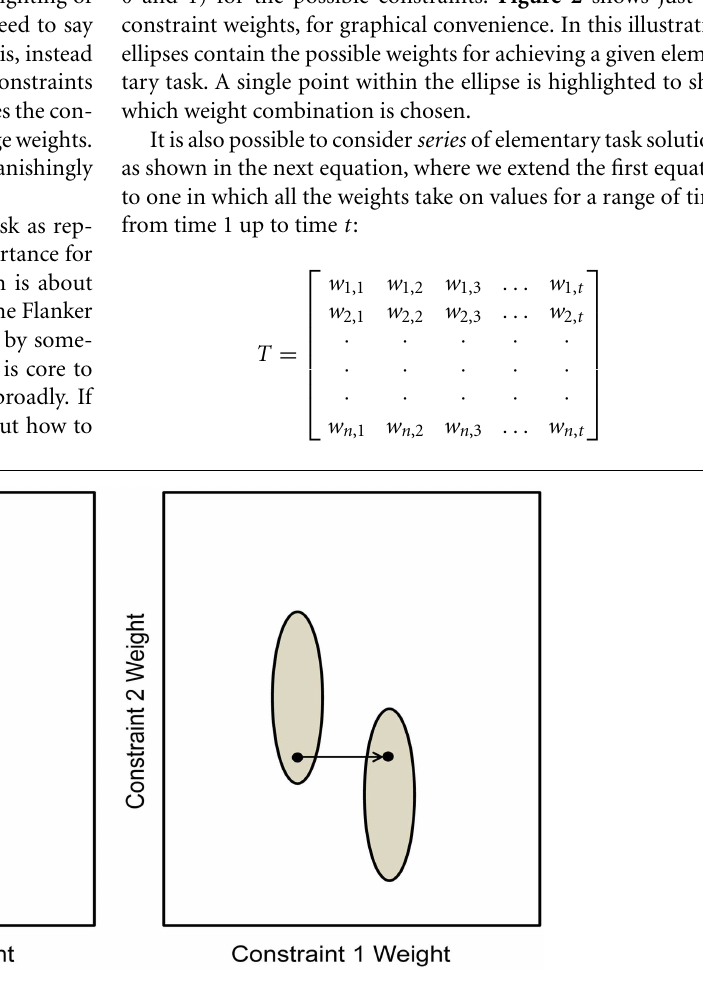
FIGURE 2 |Actions selected from those that satisfy elementary task demands (enclosed in ellipses) defined by their locations in the two-dimensional space of weights (0–1) for constraint 1 and constraint 2 . A different first point is chosen in the left case and second.